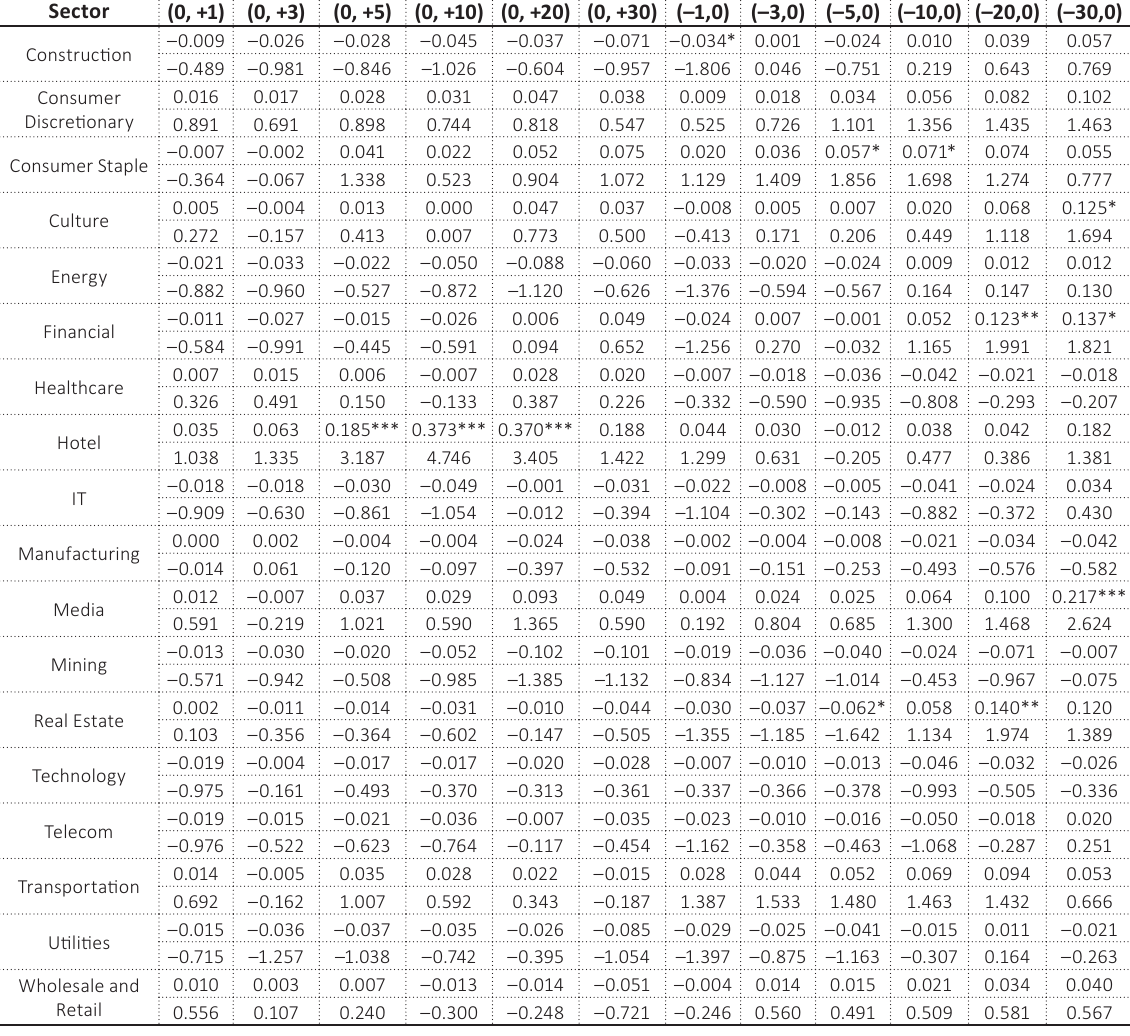
Table 1. Abnormal returns and t-statistics of different sectors of China pre-event to event and event to post-event (withdrawal of zero-COVID policy) Sector